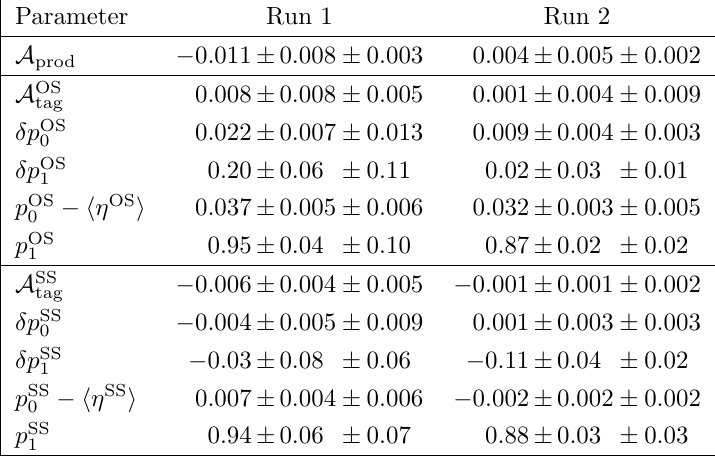
Table 1 . Flavour-tagging parameters obtained as a weighted average of the values measured in the two control channels. The quoted uncertainties are statistical and